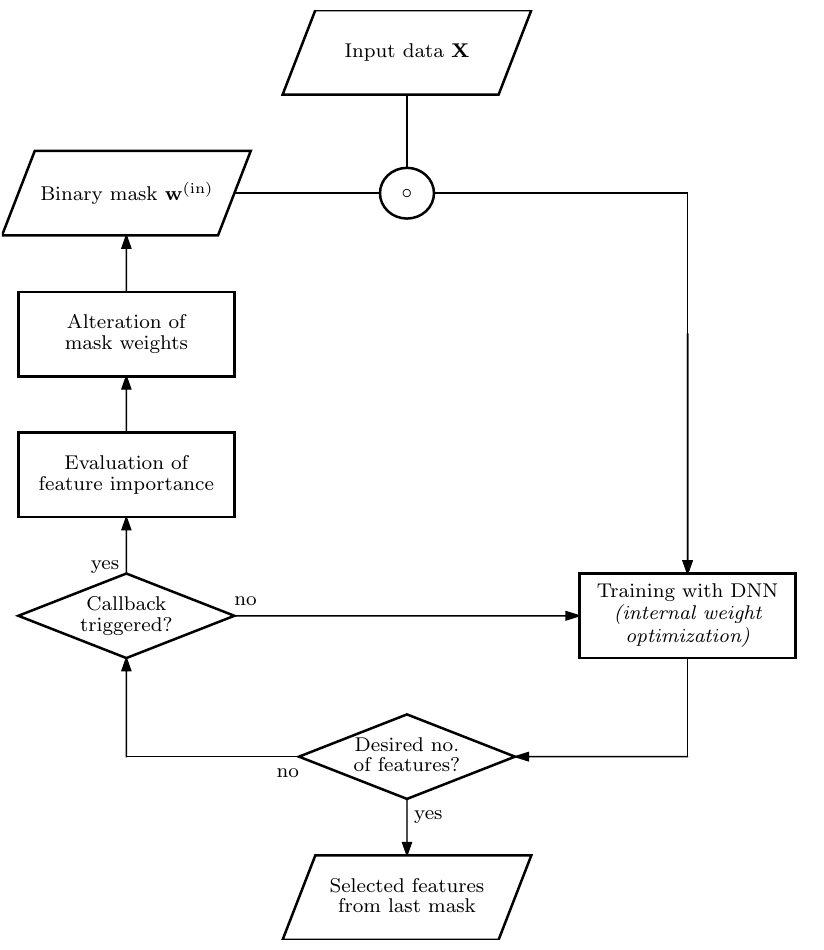
Figure 1. Process diagram of the FS callback. The ◦ -operator describes the Hadamard product. At the start of the algorithm, the complete dataset X ∈ R p × n with p features and n samples is considered and transferred to the classifier input unmanipulated, i.e., the binary mask w in ∈ R p × 1 = 1 . We use a deep neural network (DNN) as a classifier due to its inherent nonlinear properties. Its training process is executed within the lower loop in the process diagram. When the performance of the classifier is satisfyingly reliable and the callback is triggered, the algorithm exits the lower loop and enters the upper evaluation part. In this part, the importance of each feature is evaluated and a distinct proportion of the most informative features is selected. All of the others are pruned and neglected in ensuing optimization loops. This is done by altering the weights of the binary mask w ( in )